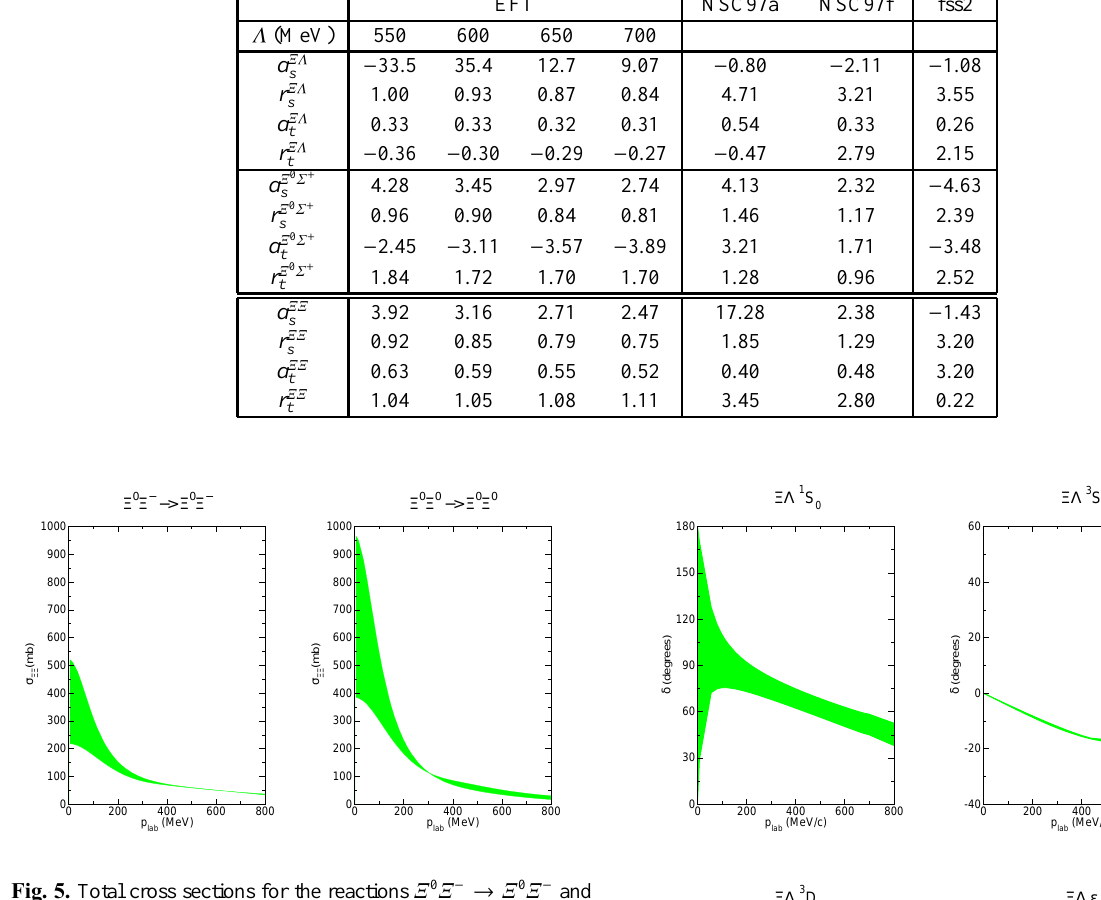
Fig. 5. Total cross sections for the reactions Ξ 0 Ξ − Ξ 0 Ξ 0 Ξ 0 Ξ 0 as a function of p lab . The shaded band shows the → chiral EFT results for variations of the cut-o ff in the range Λ = 550 . .. 700 MeV.